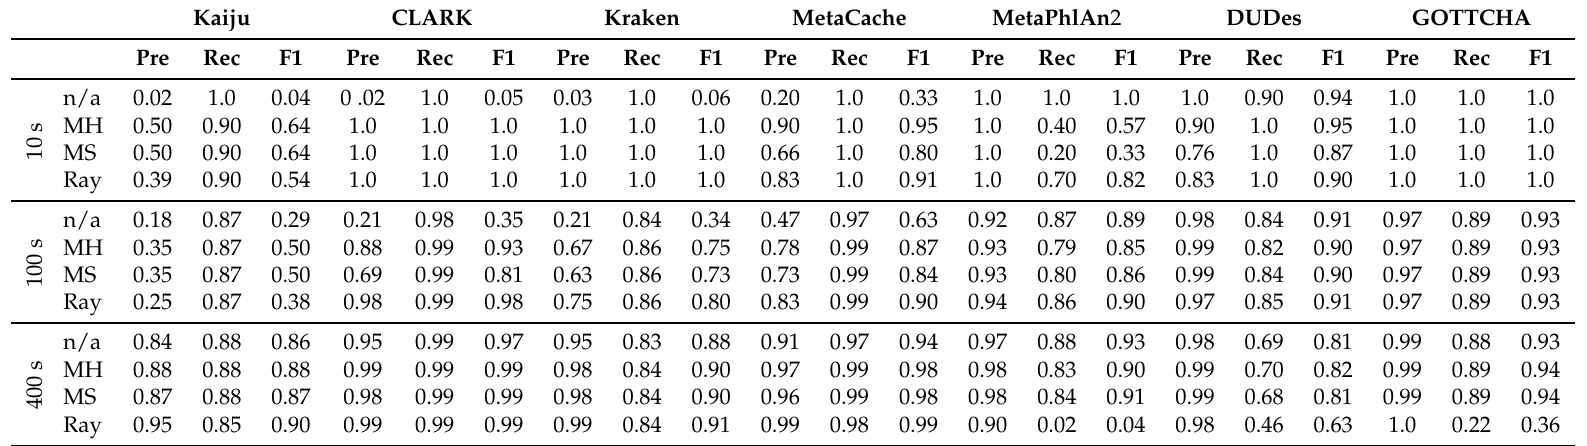
Table 1. Precision, recall, F-1 of species-level classification of four metagenomic classifiers on three synthetic short read datasets, which are, respectively, not assembled and assembled by three assemblers: MEGAHIT (MH), metaSPAdes (MS), and